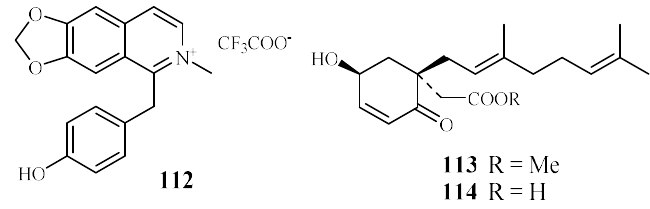
Figure 24. Compounds from Monimiaceae plants.